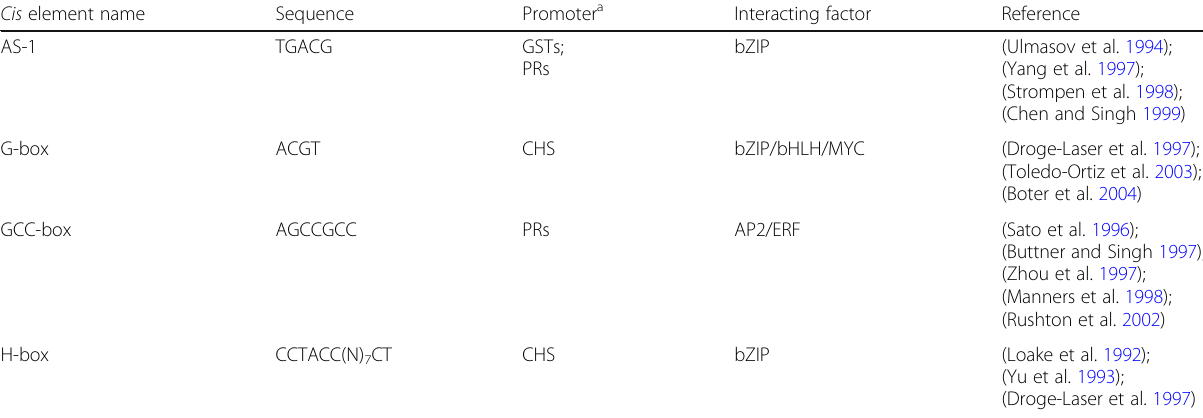
Table 1 Pathogen-inducible cis- elements, sequences and interacting factors